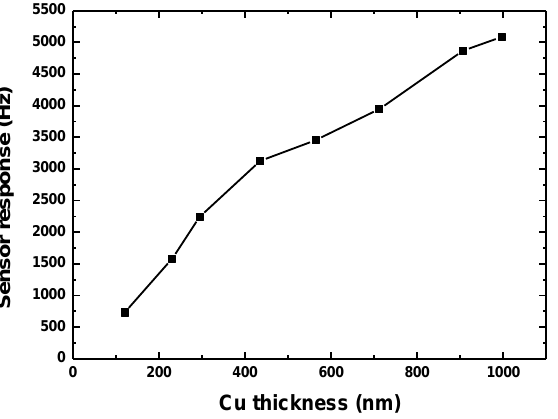
Figure 8. Measured sensor response depending on thickness of Cu dots in case rotation of 300 deg/s was applied.